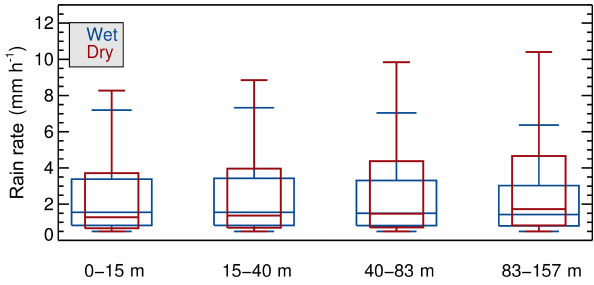
Figure 13. Wet and dry season rainfall rate (RR) box plots for dif- ferent topography classes. Each box represents the 25 to 75% pop- ulations, and the line inside the box represents the median value. The line represents the remaining